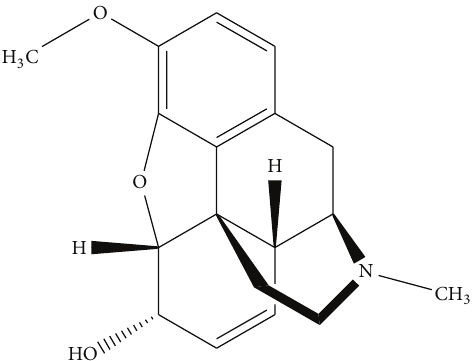
Scheme 1: Molecular structure of